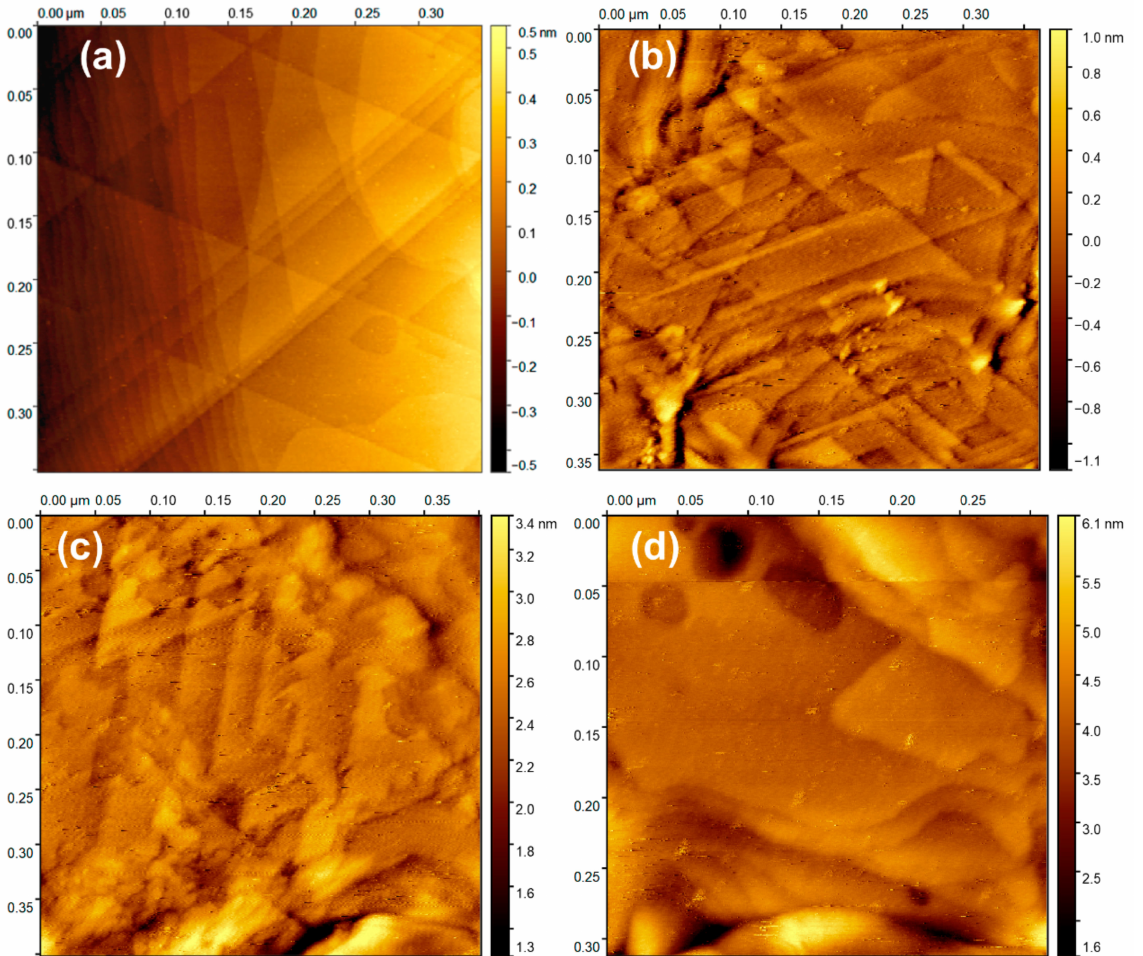
Figure 4. STM images of air conditions, collected in constant-current mode, of modified surface electrodes: ( a ) bare gold electrode; ( b ) Au/ mL -ArNH 2 ; ( c ) Au/ i -ArNH 2 ; and ( d ) Au/ ML -ArNH 2